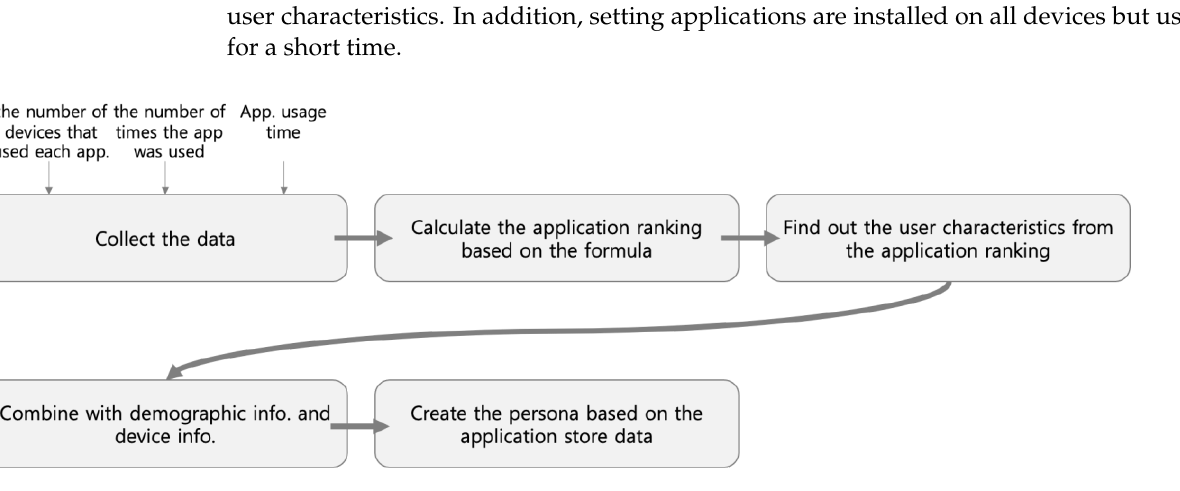
Figure 3. Method to determine the top-n applications.